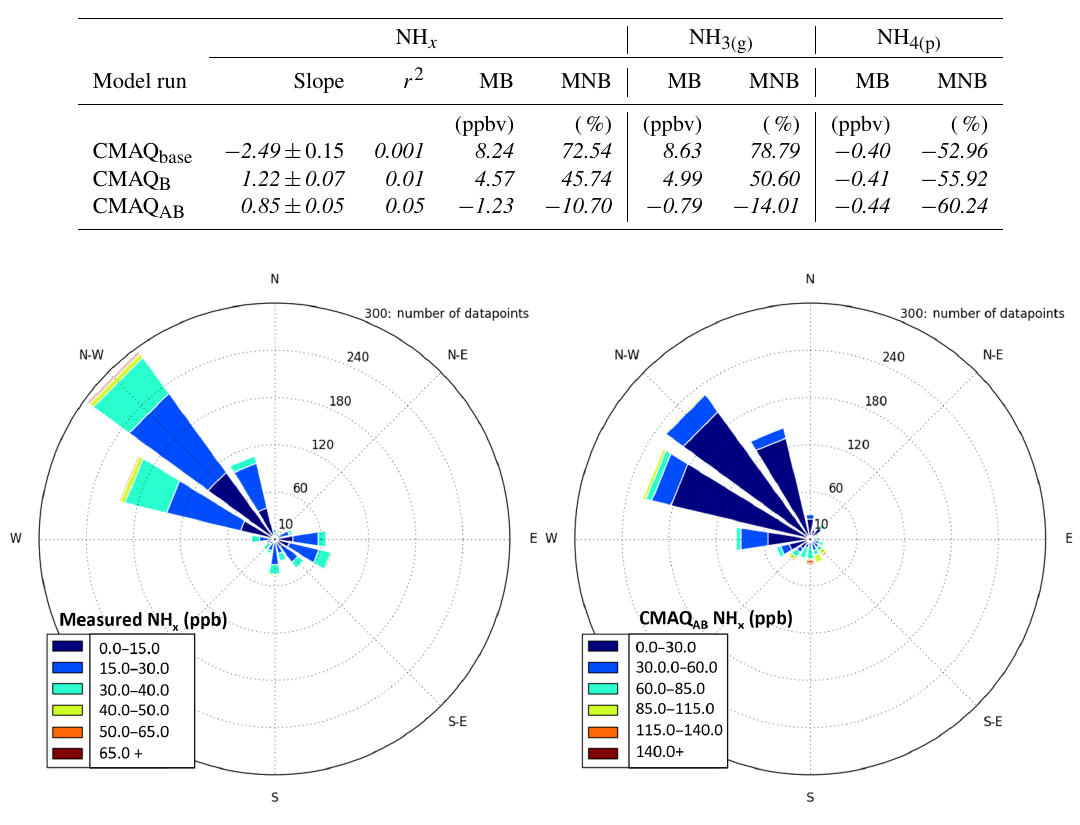
Figure 3. Wind rose of measured wind direction and NH 3 on the left, and CMAQ AB modeled wind direction and NH 3 on the right where contours represent the number of data points (hourly) per wind direction. Note the difference in scale, where values are in